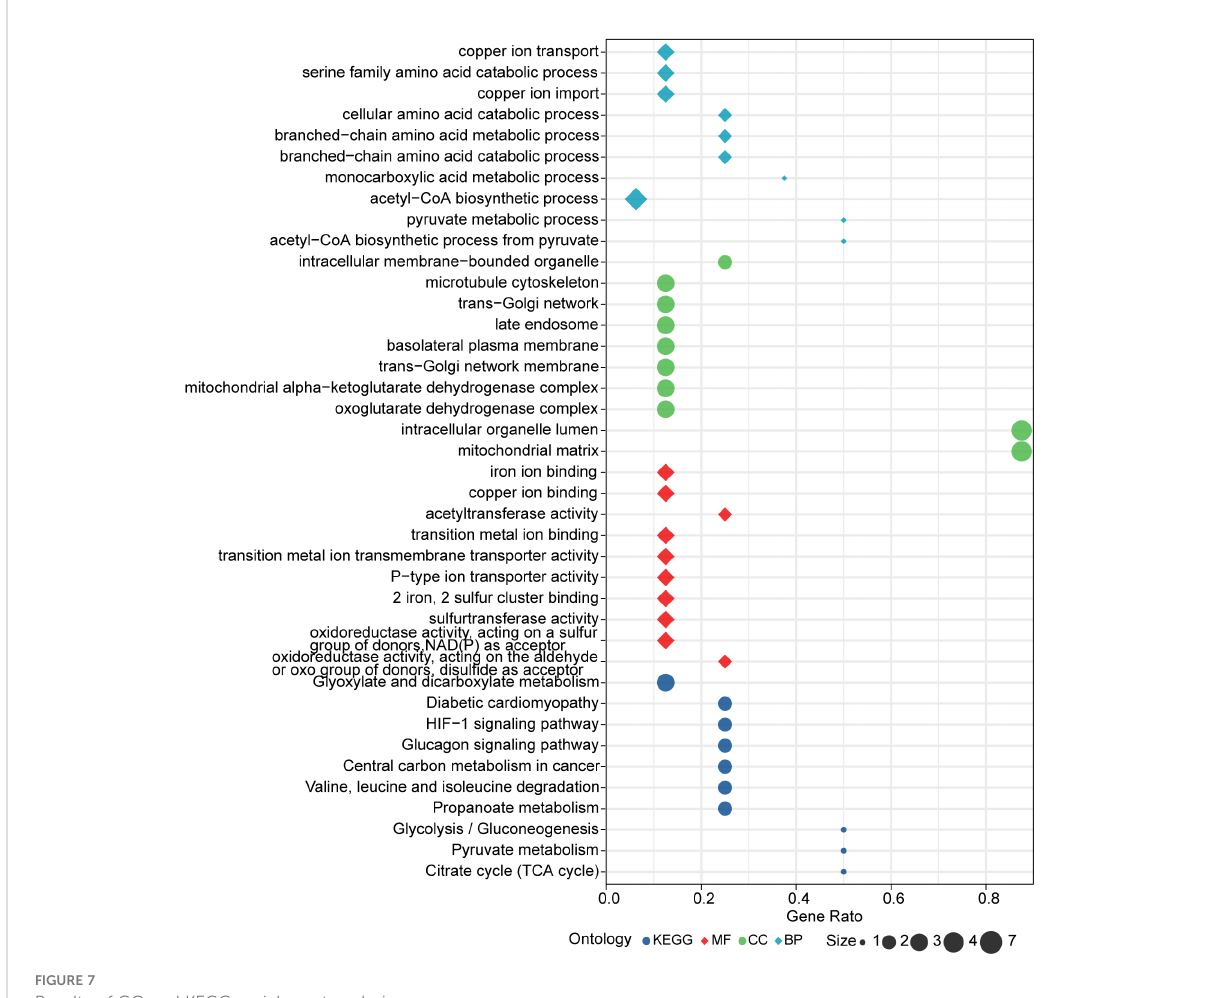
FIGURE 7 Results of GO and KEGG enrichment